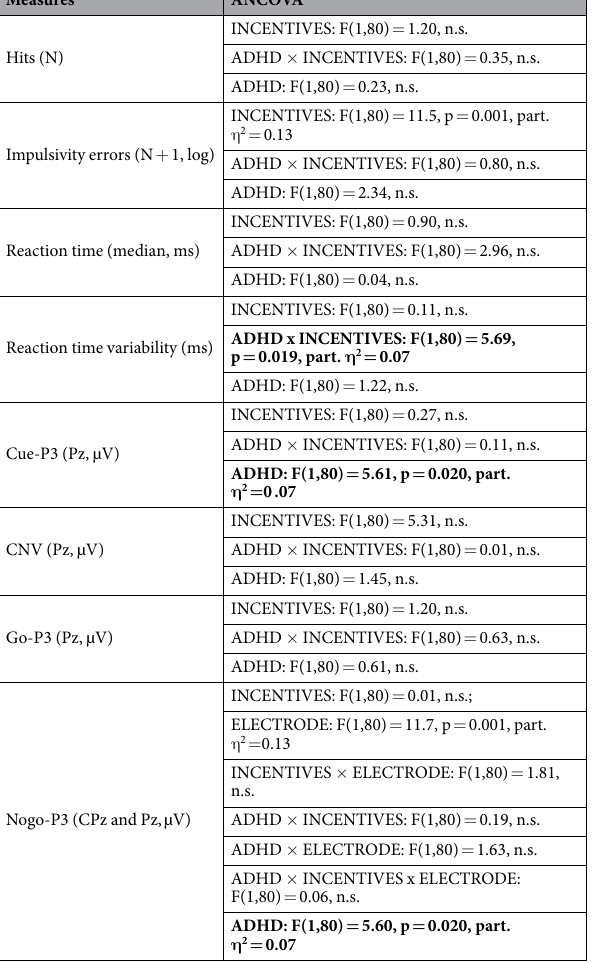
Regarding reaction time variability, a significant ADHD × INCENTIVES interaction effect (medium effect size; F(1,80) = 5.69, p = 0.019, part. η 2 = 0.07) was obtained due to a larger influence of motivational contingen- cies with increasing FBB-ADHS total score. For the other performance parameters, no significant effects related to ADHD could be found (F(1,80) ≤ 2.96, p ≥ 0.089). For Cue-P3 and Nogo-P3, significant ADHD effects could be revealed (medium effect sizes; F(1,80) ≥ 5.60, p = 0.020, part. η 2 = 0.07) indicating smaller amplitudes with increasing ADHD score. In Fig. 1, grand average ERPs for cue trials, go trials and nogo trials are depicted. Reduced Cue-P3 and Nogo-P3 amplitudes in boys with the highest ADHD scores (not depending on the INCENTIVES condition) are evident. For CNV and Go-P3 amplitudes, no significant effects regarding ADHD or ADHD × INCENTIVES interactions were obtained (F(1,80) ≤ 1.45, p ≥ 0.232). CNV amplitudes were higher in blocks with motivational incentives compared to blocks without incentives (as indicated by a significant INCENTIVES effect; F(1,80) = 5.31, p = 0.024, part. η 2 = 0.06). Comparing children with FBB-ADHS scores in the normal range ( ≤ 0.5, Controls, N = 40) and children with FBB-ADHS scores in the clinical range ( > 1, ADHD-high, N = 13) regarding the difference in reaction time p ≤ 0.026; see also Table S1).